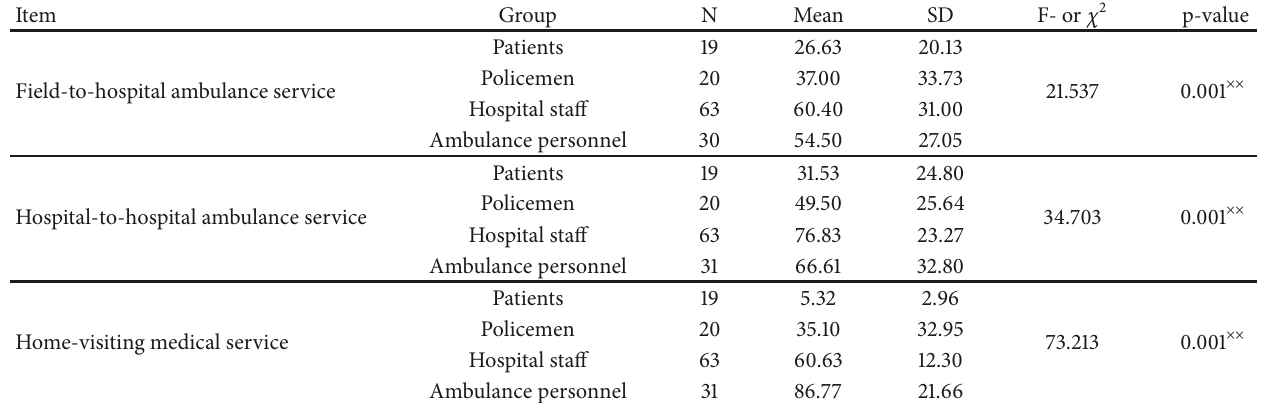
Table 3: The estimated costs for emergency ambulance services (Units: frequency,